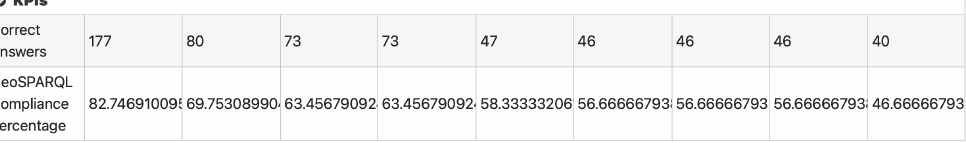
Figure 3. Results from the GeoSPARQL compliance benchmark, from the public instance of the HOBBIT